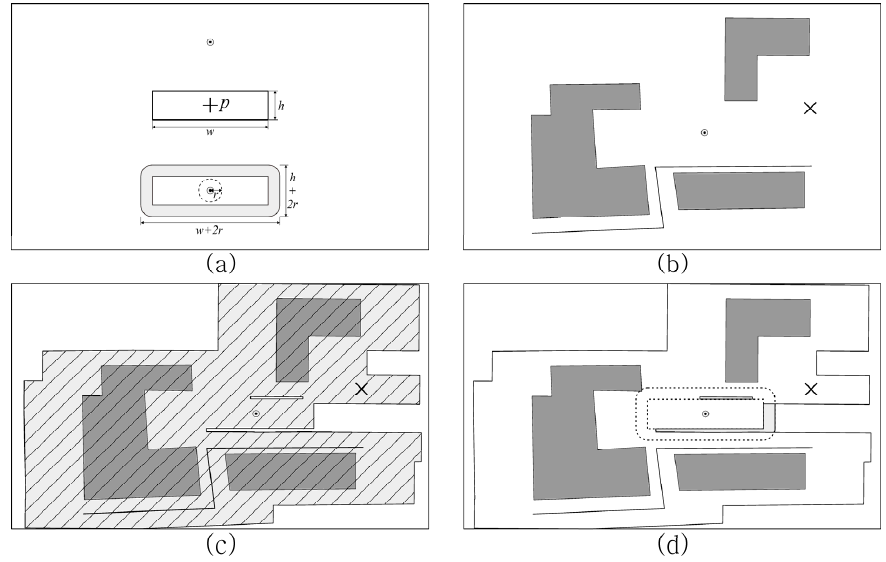
Figure 6. The flow diagram of the candidate label region generation. ( a ) Point feature, label textbox, and search space; ( b ) a label placement case; ( c ) the generated region of immovability; ( d ) the conflict-free labeling space.